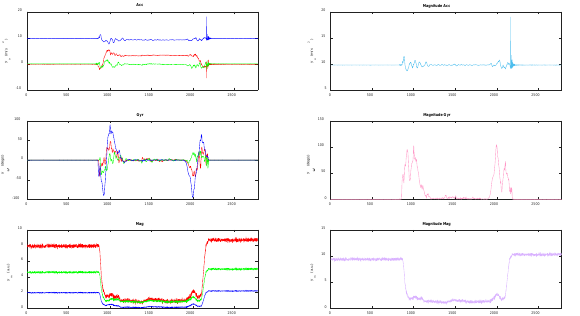
Figure 7: Input signals for in-use IMU self-calibration. The IMU was treated as a smartphone or tablet. The user reached for it on the table, and returning it after pretending to check for some messages. The red, green, and blue in the left column represents the x, y, and z components, respectively.